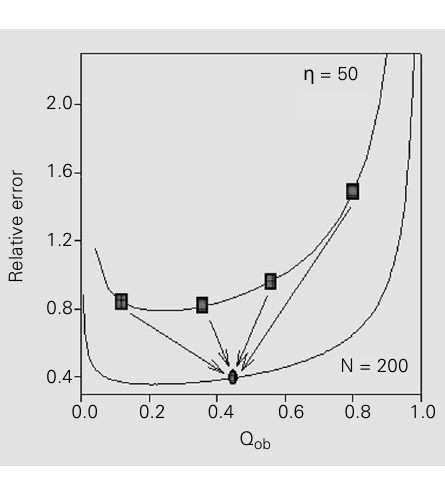
Figure 1 - Relative error of p (or f) in relation to values of Q ob for a given N. The graph is obtained by numerically solving equations 6a and b for Q ob ranging from 1/N to (N -1)/N at 1/N steps (i.e., a numerical search for values of Q low and Q high for each Q ob in the range) and then computing the relative error (equation 9, see text). Notice that the relative er- ror function has a nadir around Q ob = 0.21.